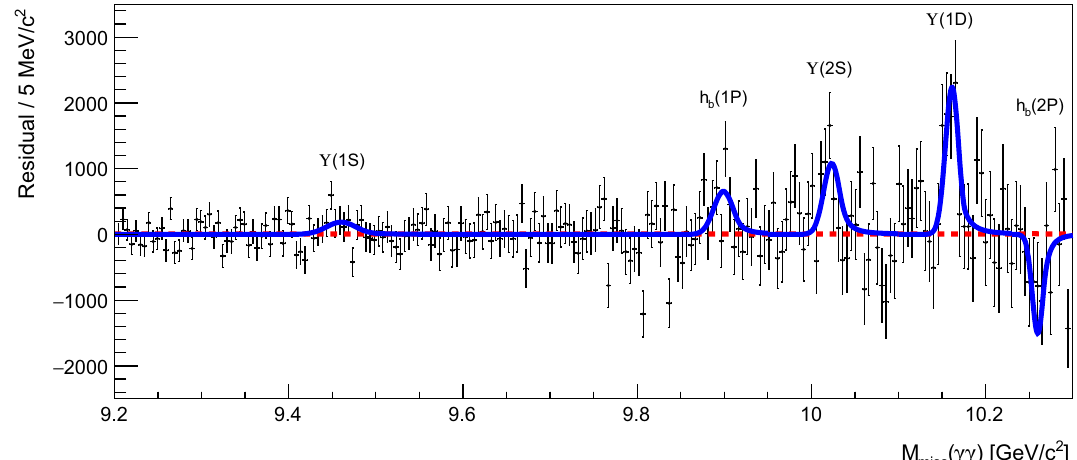
background-onlycomponent.Thebinningshownhereis50timeslarger than the one used in the fitting procedure